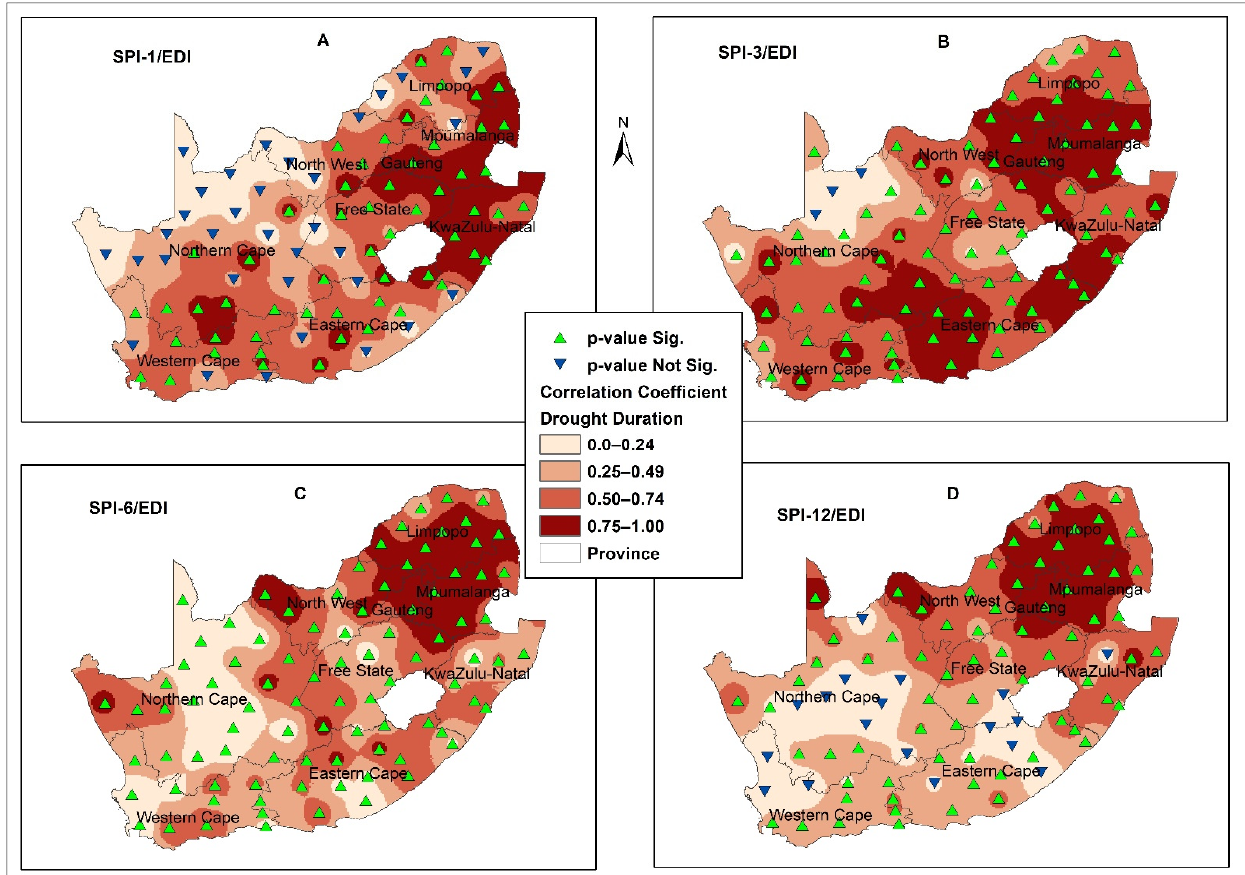
Figure 3. Pearson’s correlation coefficient estimates dissimilarity measure for drought duration in South Africa. ( A ) SPI- 1/EDI; ( B ) SPI-3/EDI; ( C ) SPI-6/EDI; and ( D ) SPI-12/EDI.